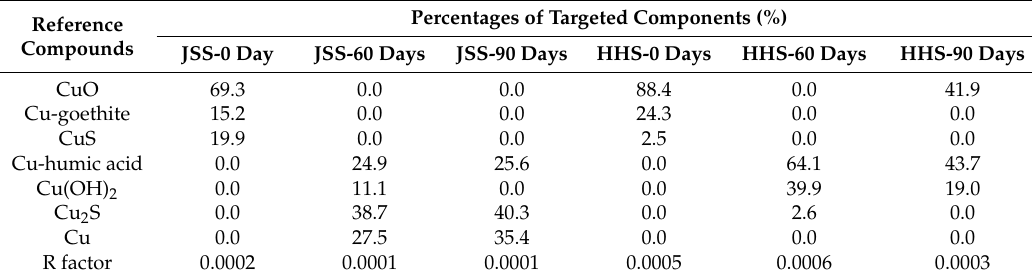
Figure 3. Comparison of Cu K-edge XANES spectra of reference compounds and different soil samples exposed to 1000 mg/kg CuO NPs. Red lines are the linear fitting results.